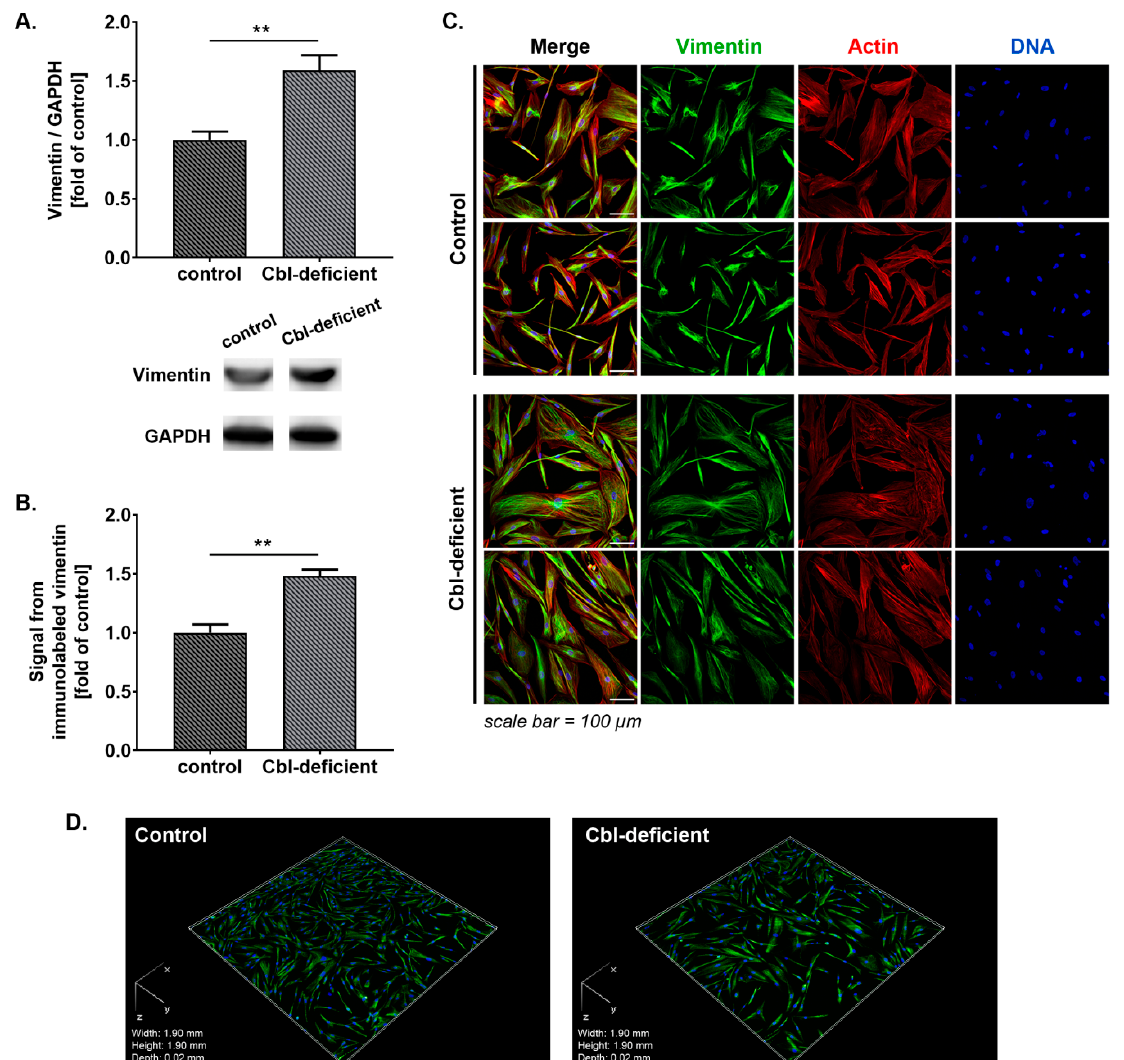
Figure 2. Stimulation of vimentin expression in astrocytes upon cobalamin deficiency. ( A ) Western blot analysis (bar graph and representative blot images) of vimentin level in control and cobalamin-deficient cells. ( B ) The total fluorescence intensity of immunolabeled vimentin normalized to cell number was quantified from z-stacked confocal images (21 stacks/image) using Nikon NIS Elements AR software. These quantifications were expressed relative to control. ( C ) Representative microscopic images of vimentin expression in cultured astrocytes; scale bar shows 100 µm. ( D ) Example 3D reconstruction of the confocal z-stack images of cultured astrocytes immunolabeled against vimentin. Data in bar graphs correspond to mean ± S.D. values from three independent experiments in at least duplicate; statistically significant differences are designated as ** p < 0.01 for comparisons between groups using unpaired t-test.